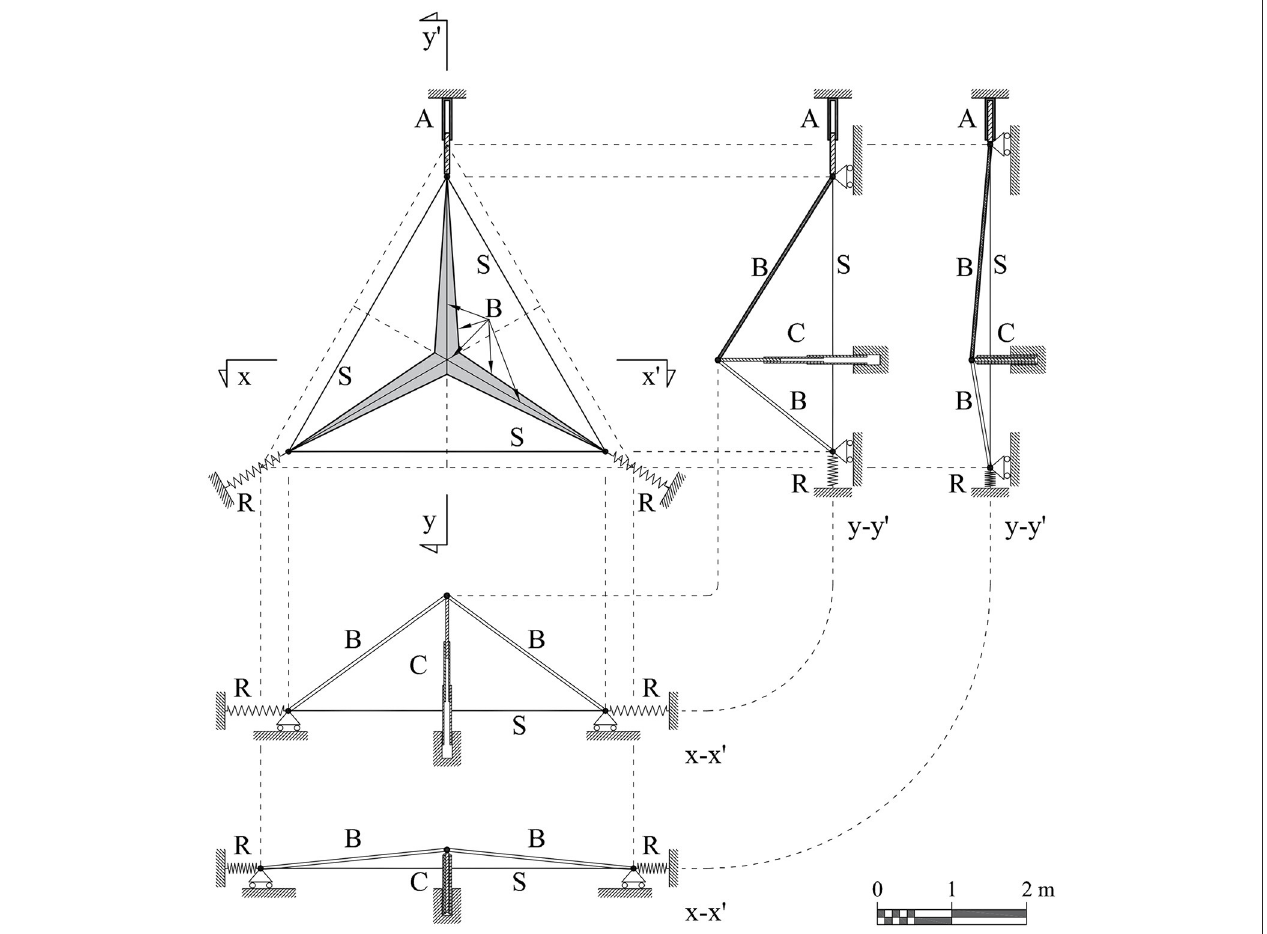
FIGURE 2 | Schematic views of the TABS concept: top view and mid-plane sections (in two different configurations): A, linear actuator; B, bars; C, telescopic collar; R, elastic restraints; S, perimeter strings. Restraints are idealized and not reported in scale.